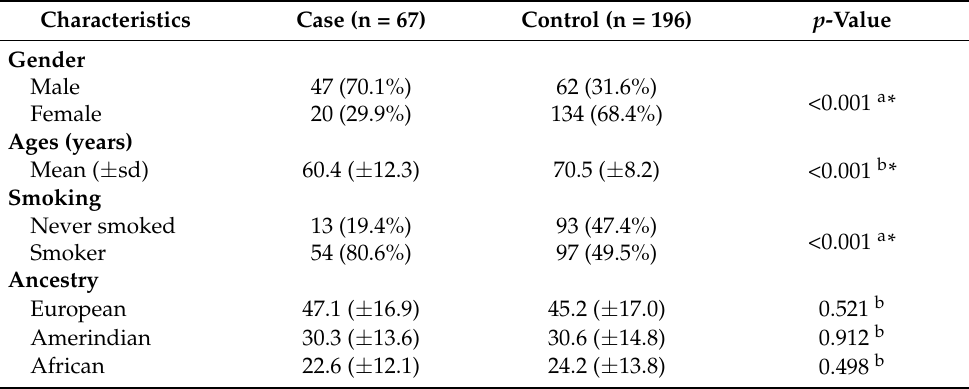
Table 3. Demographic and clinical characteristics of the investigated